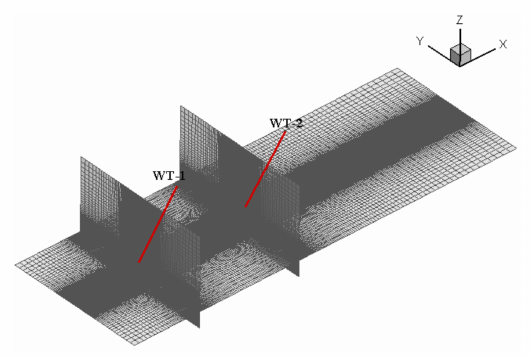
Figure 3. Medium-density mesh in the computational